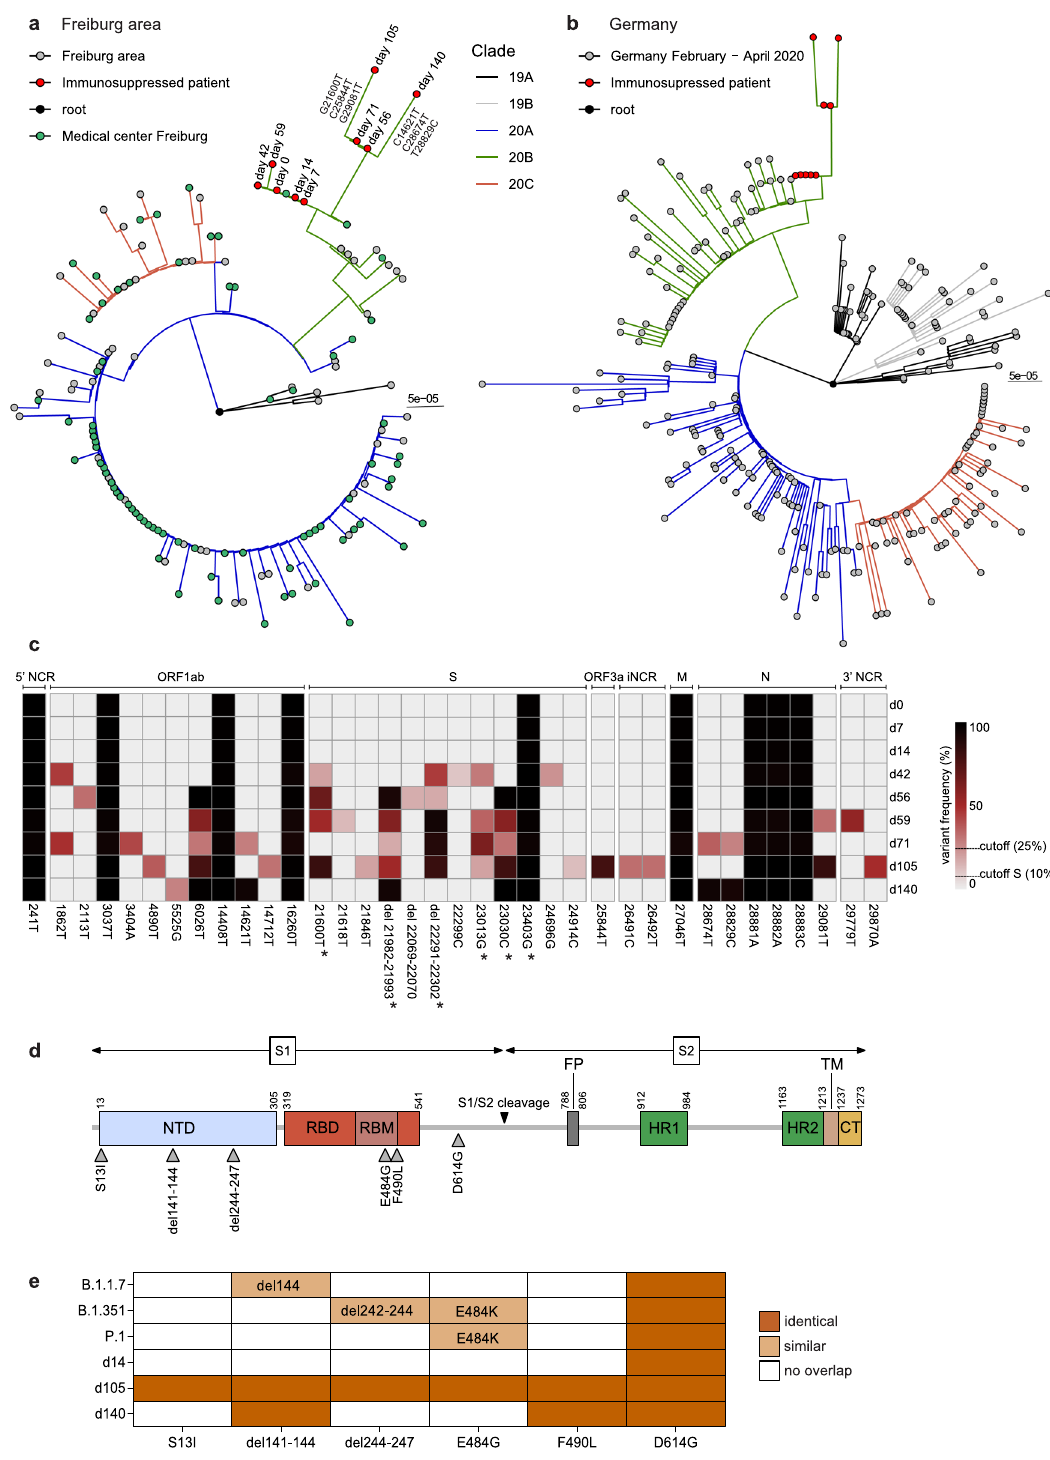
and human lung adenocarcinoma Calu-3 cells, both isolates grew to comparable titers (Fig. 4d, e). To con fi rm the growth phenotype of d105 in vivo, K18-hACE2 mice encoding the human SARS-CoV-2 receptor, angiotensin-converting enzyme type 2 (ACE2) 20 were intranasally infected with two different doses of the d14 and d105 isolates (200 or 2000 plaque-forming units (pfu)). The infected animals showed a pronounced weight loss within 4 to 8 days and only about 25 – 30% of the animals infected with 200 pfu survived the infection, whereas all animals